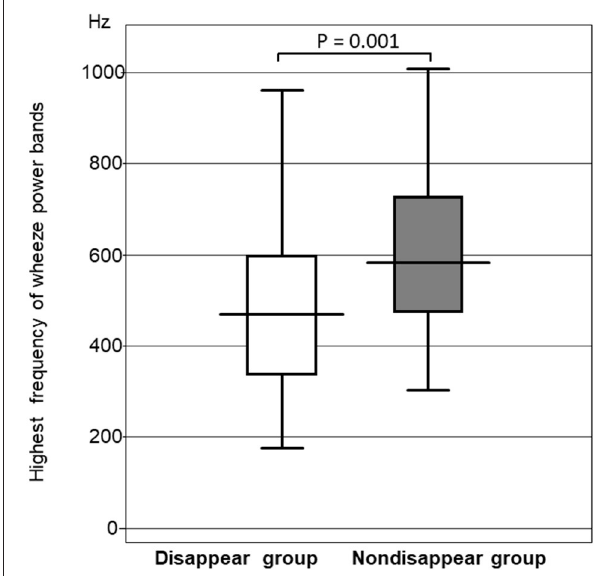
FIGURE 3 | Comparison of the highest frequency of wheeze power bands between the two groups.